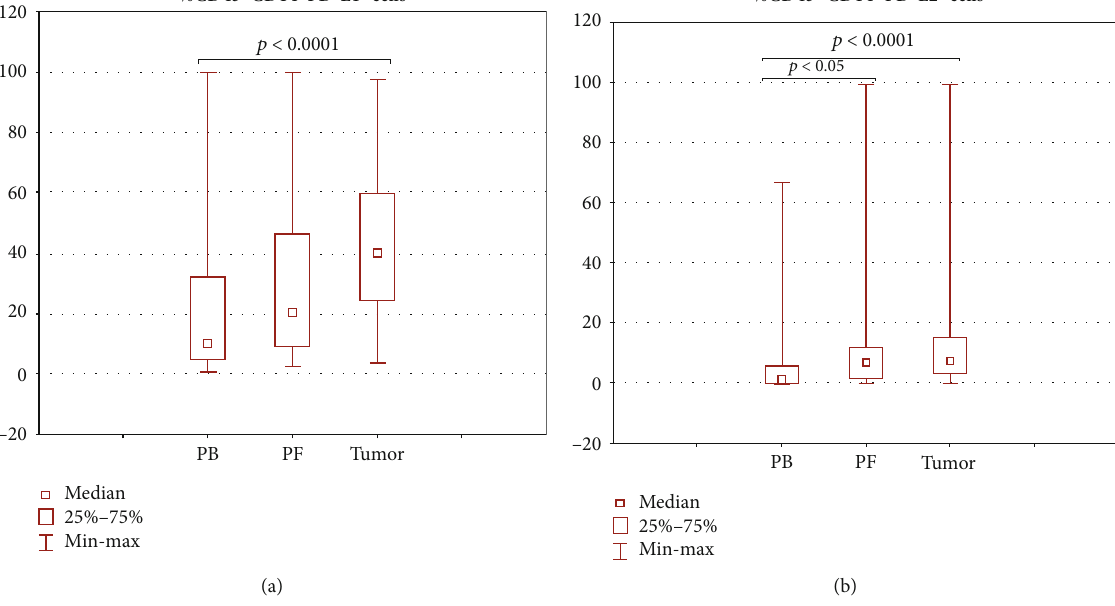
Figure 5: Percentage of CD45 + CD14 + cells with expression of (a) PD-L1 and (b) PD-L2 in the TMEs of OC